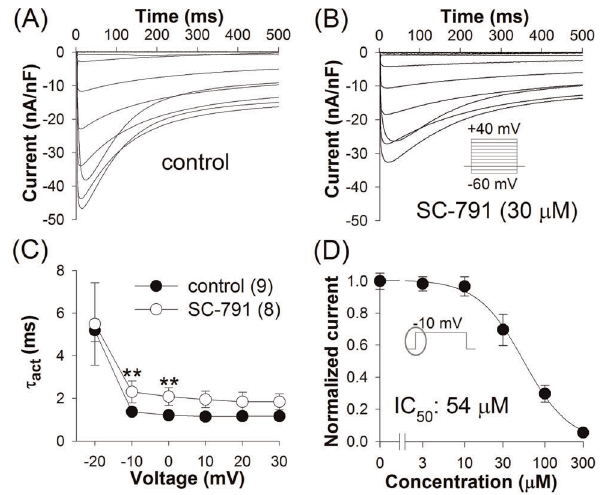
Figure 1. Inhibition of L-type Ca 2 + channels by SC-791. L-type currents in larval body-wall muscles in control ( A ) and in the presence of 30 m M SC-791 ( B ) were elicited by 500 ms voltage pulses between 2 60 and + 40 mV in 10 mV increments from a holding potential (HP) of 2 40 mV; averaged traces are shown. ( C ) SC-791 slowed activation of L- type Ca 2 + channels. Activation time constants were determined by fitting the rising part of the current with a single exponential function; (n), number of experiments. ( D ) Dose-response relation for inhibition of the peak L-type current by SC-791 at 2 10 mV; the curves in this and following dose-response relations represent fits to Hill